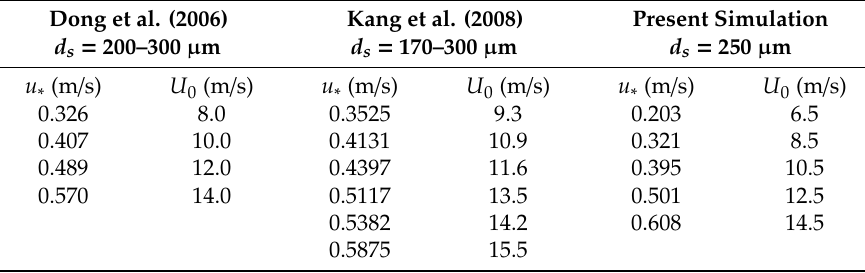
Table 1. Values for the friction velocity u ∗ at d s ≈ 250 µ